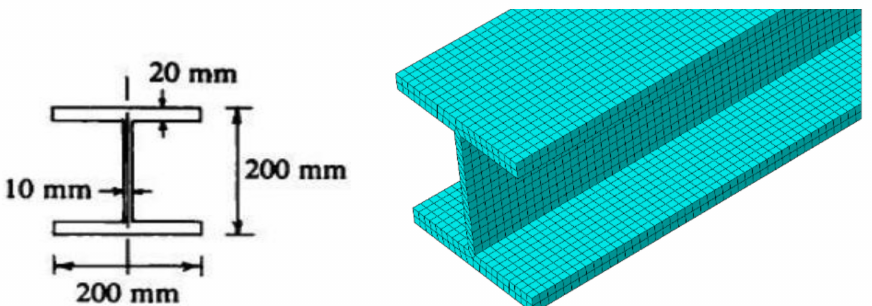
Figure 15. Cross-sectional dimensions and mesh of the beam.